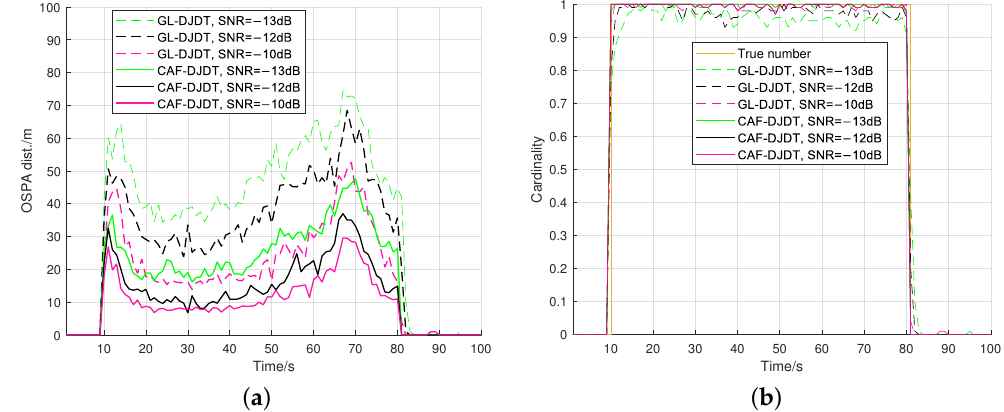
Figure 3. Comparision of two DJDT methods with different SNRs. ( a ) OSPA errors of two DJDT methods with different SNRs; ( b ) Cardinality of two DJDT methods with different